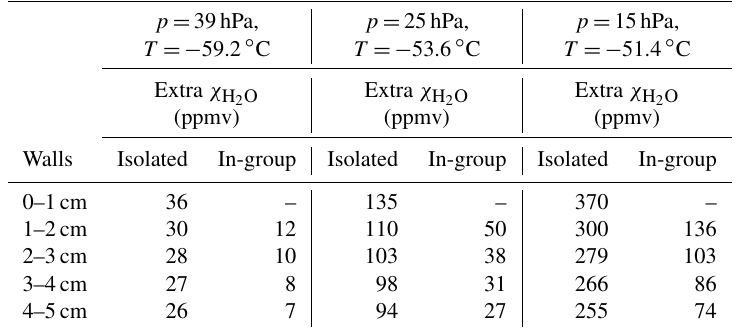
∼ 4ppmv. The 2 O 2 O